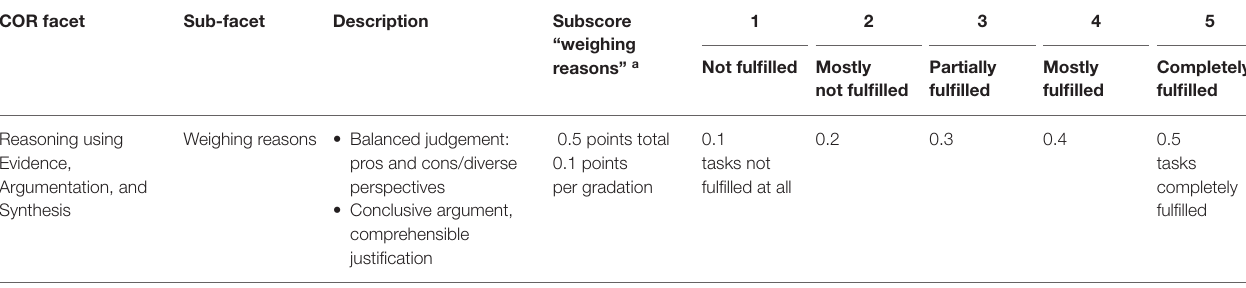
TABLE 3 | Excerpt of the COR scoring scheme; REAS facet, sub-facet “weighing reasons.” COR